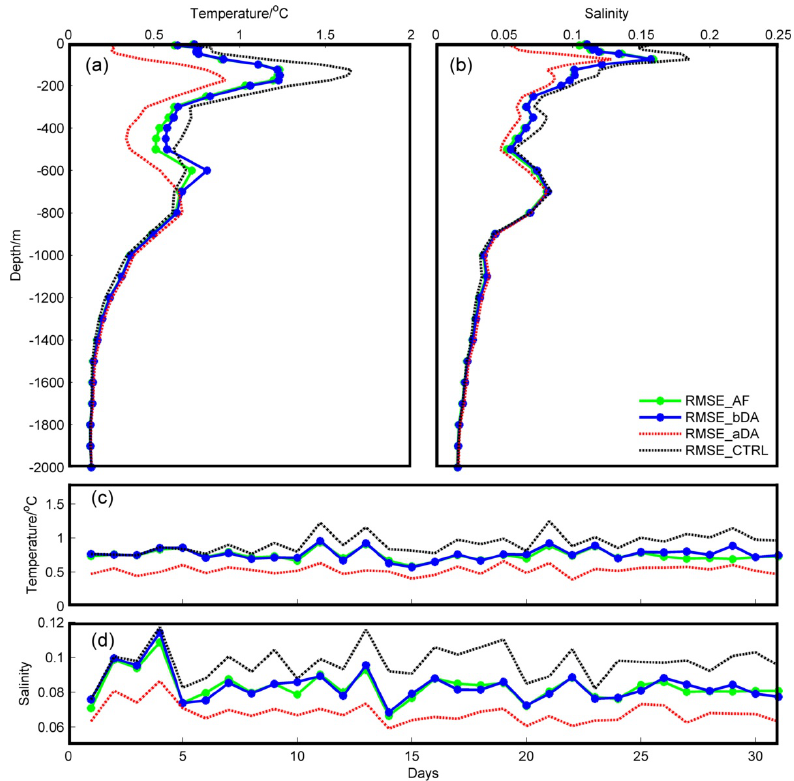
Figure 13. Vertical (a, b) and temporal (c, d) evolution of T/S RMSE: green solid line represents the RMSE of the AF run, the blue solid line represents the RMSE of bDA run, the red dotted line represents the RMSE of the aDA run and the black dotted line represents the RMSE of CTRL run.